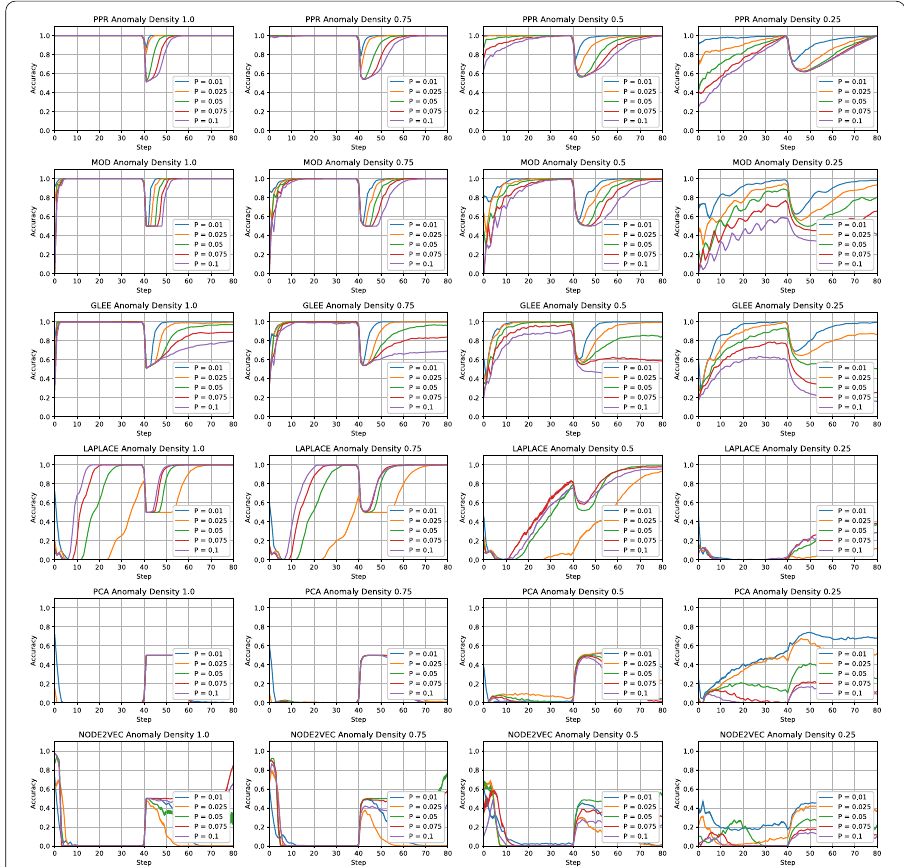
Fig. 8 Accuracy index versus time step for all tested embeddings and configurations. The results are arranged from top to bottom by the embedding type: PPR, MOD, GLEE, Laplacian, PCA, and Node2Vec. The anomaly density value for each plot represents the edge density of the anomaly or target subnetwork and P represents the density of the background network. The anomalies get sparser from left to right, causing the discovery task to increase in complexity and in general for the performance of each embedding to diminish. On the other hand, for a fixed anomaly density value, decreasing the background density P makes the discovery task easier. We observe that PPR, MOD, GLEE, and Laplacian embedding all perform well on the task and PPR maintaining the best performance. Note that the sharp dips in the plots correspond to regions when the agent has to travel from the first anomalous subnetwork to the second and there are no target nodes in the boundary